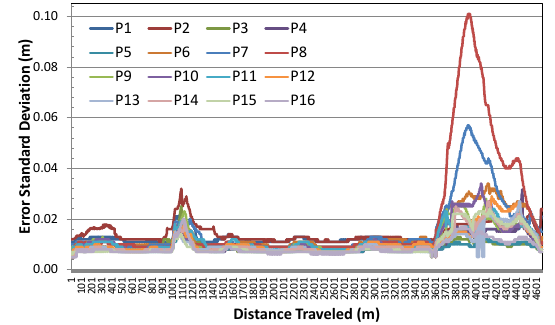
Figure 7. Error standard deviation computed during the determination of the trajectory. Note that the solution is significantly poorer due to satellite obstructions that occur after chainage 3601. However, those errors vary substantially in magnitude between each pass.